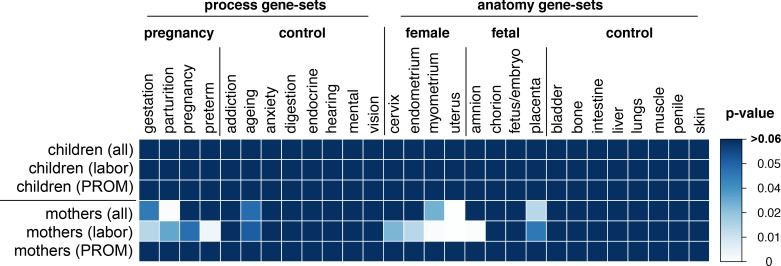
Enrichment in gene-sets generated using PubMed abstract text-mining.The figure shows an overlap between the genes implicated in six GWA analyses (rows) and genes related to specific keywords (columns). The overlap is represented as probability (p-value) of similar or greater enrichment arising due to pure chance under the null hypothesis of no enrichment (i.e., if GWAS would rank genes in a random order). The 300 top independent loci (“clumps”) and their genes were used. The name of each gene-set indicates a keyword used in the PubMed abstract mining. The INRICH algorithm was used to estimate empirical p-values.